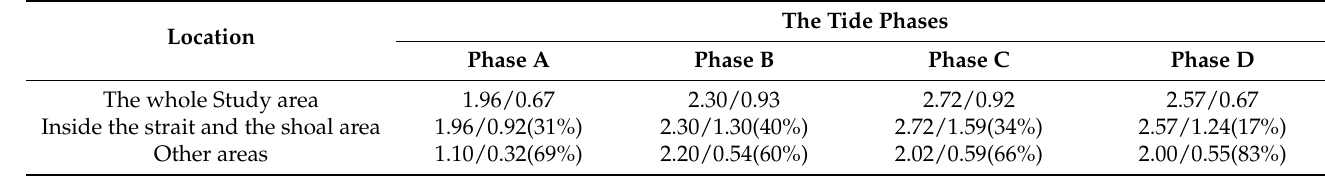
Table 1. The tidal current velocity in different tide phases at the east entrance of the Qiongzhou Strait. Phase A represents ebb with an eastward current. Phase B represents flood with a westward current. Phase C represents ebb with a westward current. Phase D represents flood with an eastward current. The number before the slash shows the maximum velocity and the number behind the slash shows the average velocity, with unit of m·s − 1 . The number in the bracket shows the distribution proportion of the statistical scope.